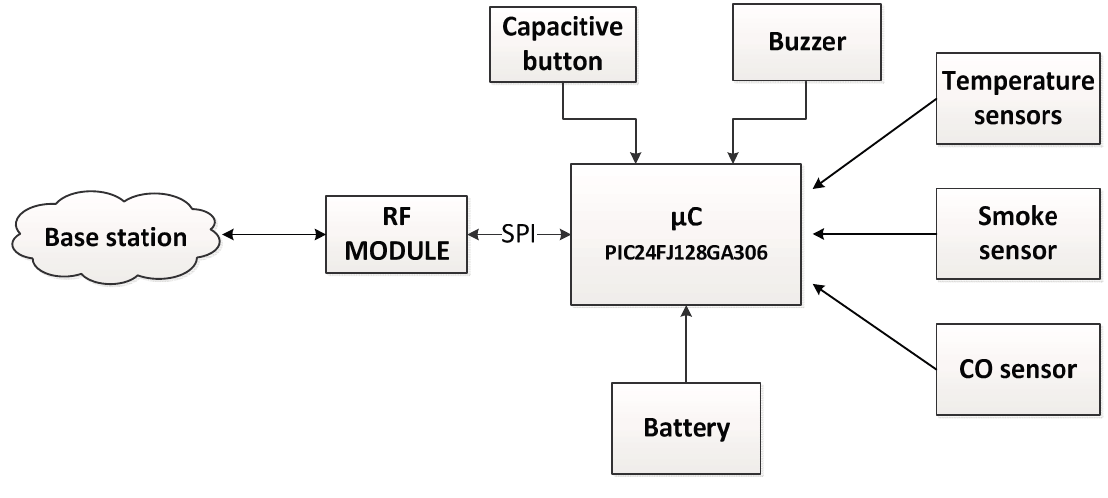
Figure 1. Building blocks of the sensing